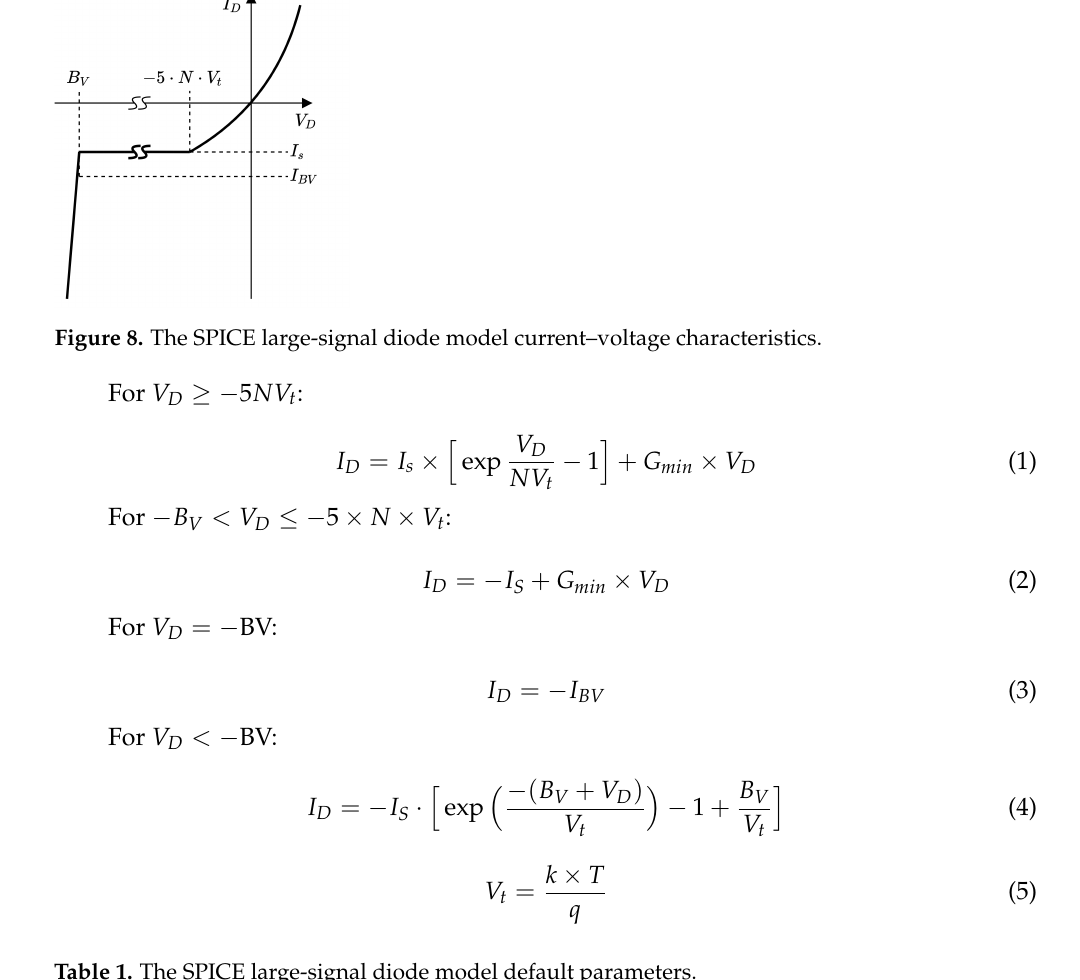
Table 1. The SPICE large-signal diode model default